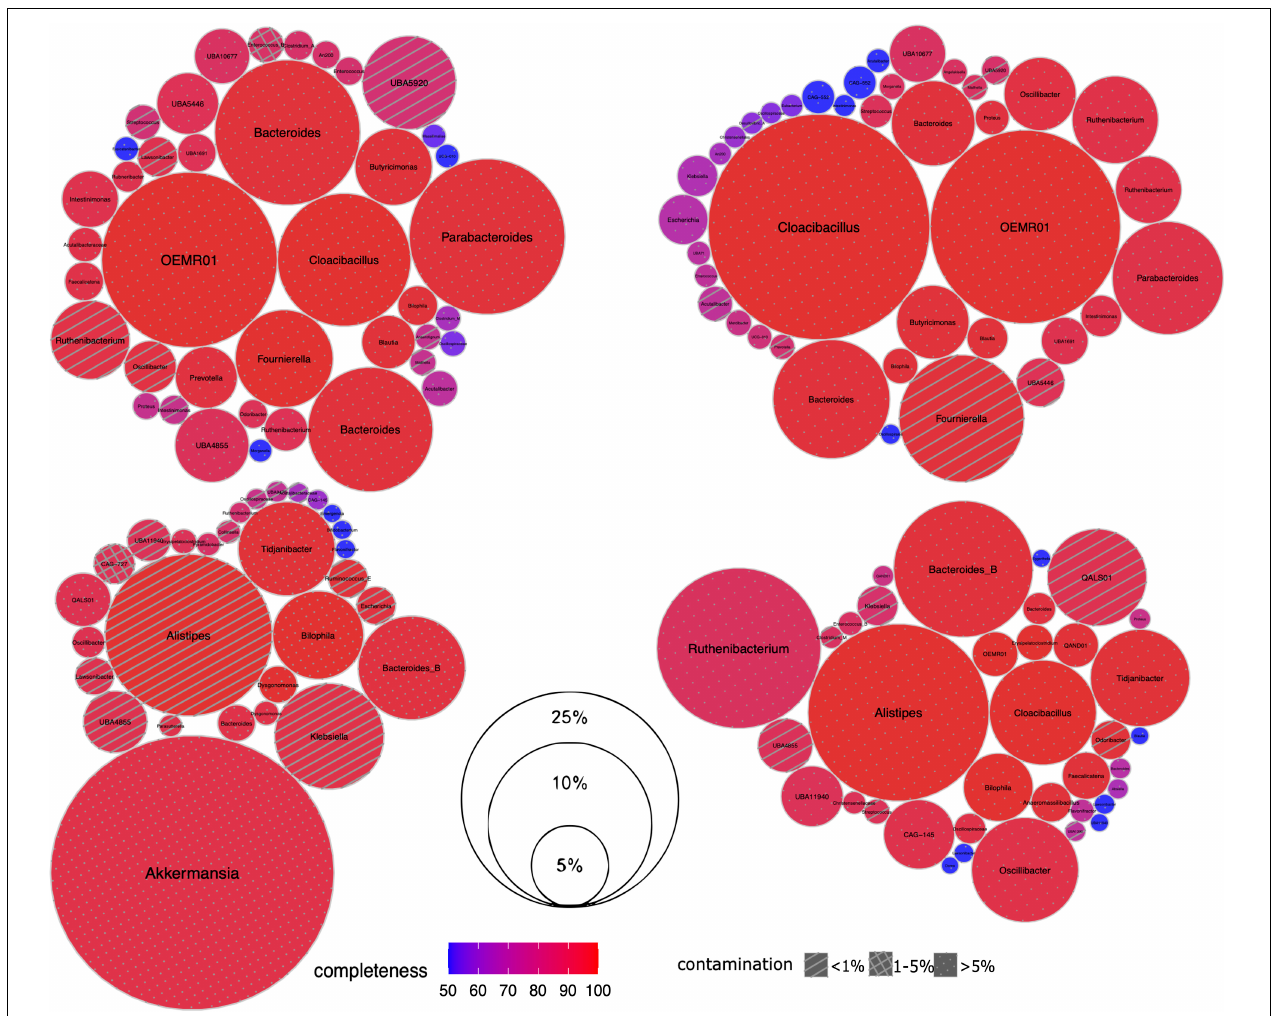
FIGURE 2 | Taxonomic composition of gut microbiome in CCI patients. For each sample, its set of recovered Hi-C MAGs ( via hicSPAdes) is visualized as circle packing. Each circle represents a MAG labeled with genus-level taxonomy; MAG relative abundance (normalized by the total length of its contigs) is shown as its diameter, completeness – as color, and contamination – as fill pattern. Sample IDs from left to right, top to bottom: IC4, IC5, IC6 and IC9.